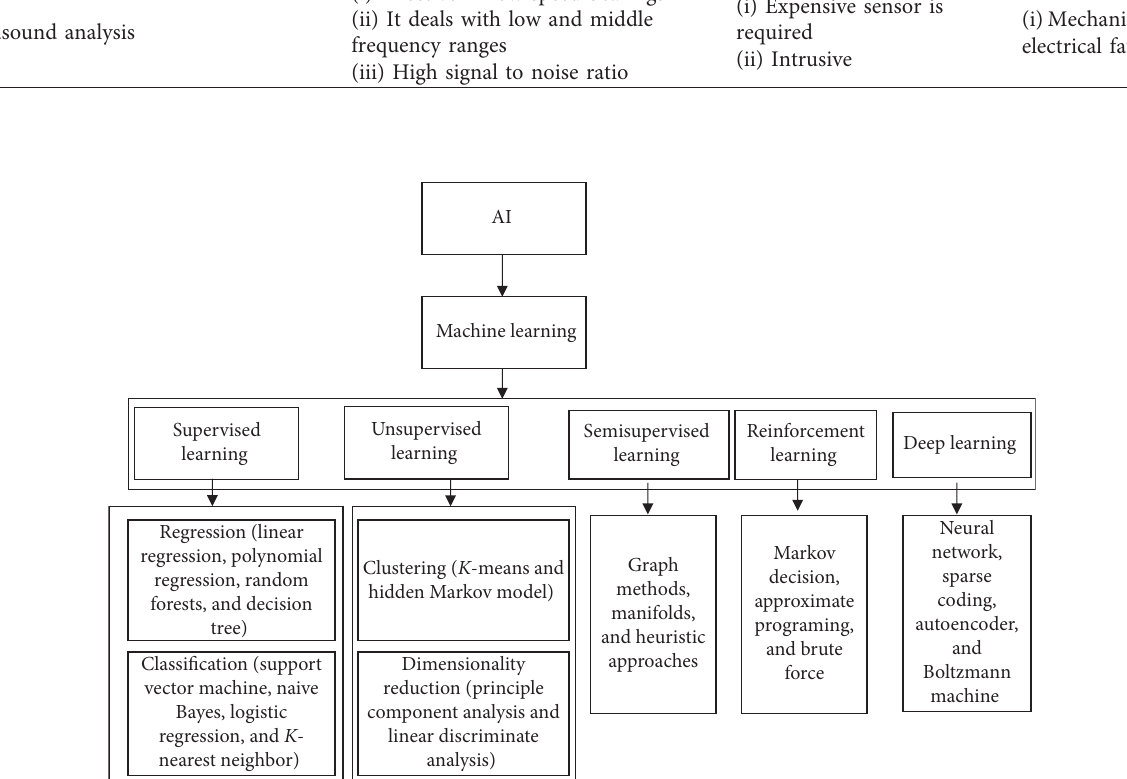
Figure 6: AI methods used in CM and FDD for rotating